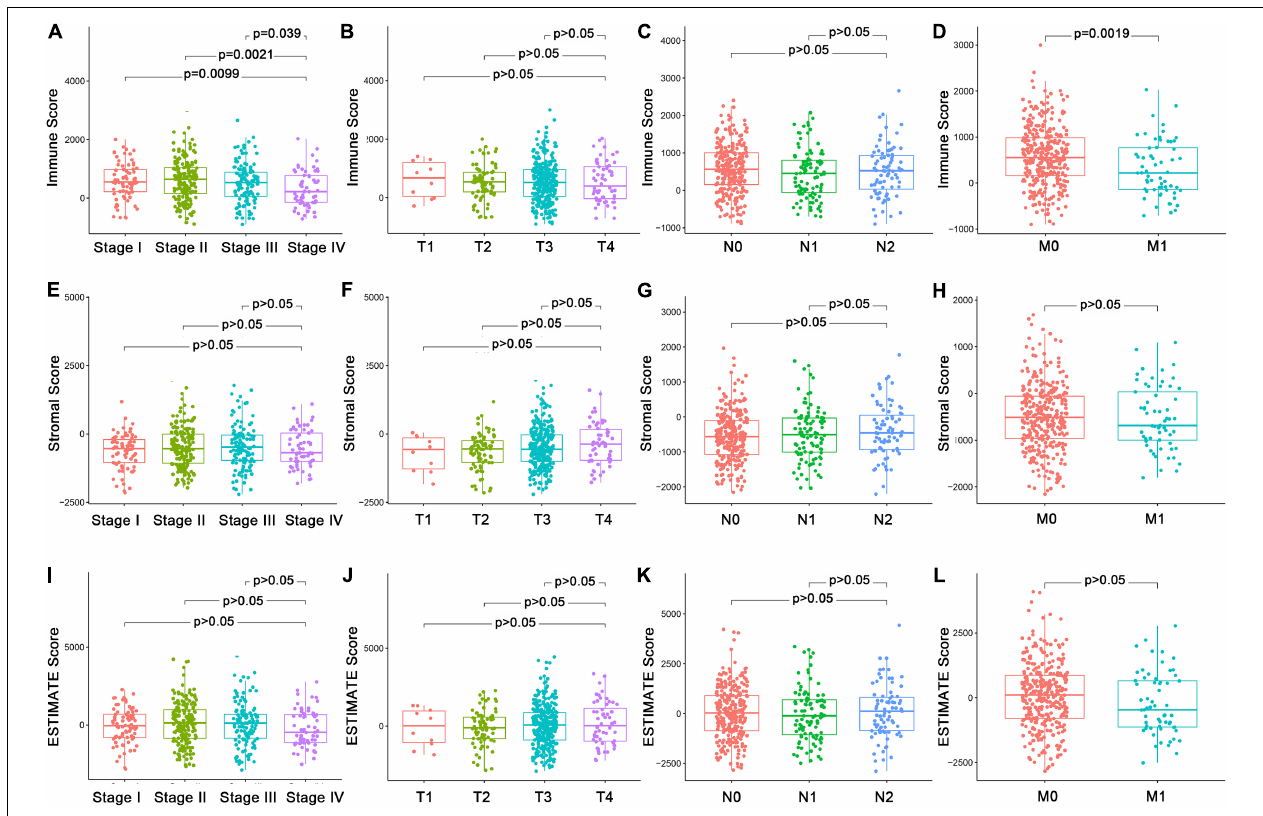
FIGURE 1 | Association of Immune Score, Stromal Score, and Estimate Score with the clinic–pathological features of CC Patients. (A–D) Association of Immune Score with stages and TNM classification by Kruskal–Wallis rank sum test. (E–H) Association of Stromal Score with stages and TNM classification Kruskal–Wallis rank sum test. (I–L) Association of Estimate Score with stages and TNM classification Kruskal–Wallis rank sum test.